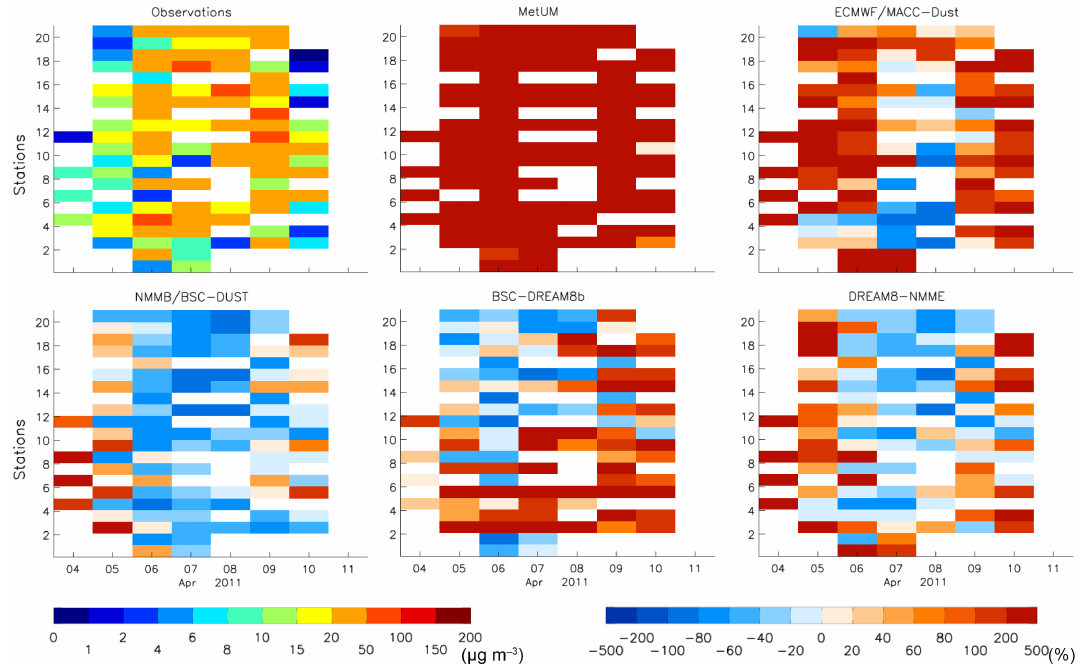
Figure 4. Daily measured surface concentration (µgm − 3 ) and normalized bias of corresponding 24h forecast surface concentration (%) at stations illustrated in Fig. 1. Each row corresponds to one of the stations. Stations are ordered from south to north, and white colour corresponds to days without measurements. Corresponding 24h forecast model surface concentrations are illustrated in Fig. S04, and the 48 and 72h of normalized bias of forecasted surface concentration are provided in Figs. S05 and S06. Table 5. Root mean square error (RMSE), mean bias and correlation quantifying the performance in reproducing dust surface concentration in the Iberian Peninsula. Figure 1 illustrates the location of the stations used in the computation of the statistics. Note that for the models, the total dust surface concentration was used. RMSE Mean bias